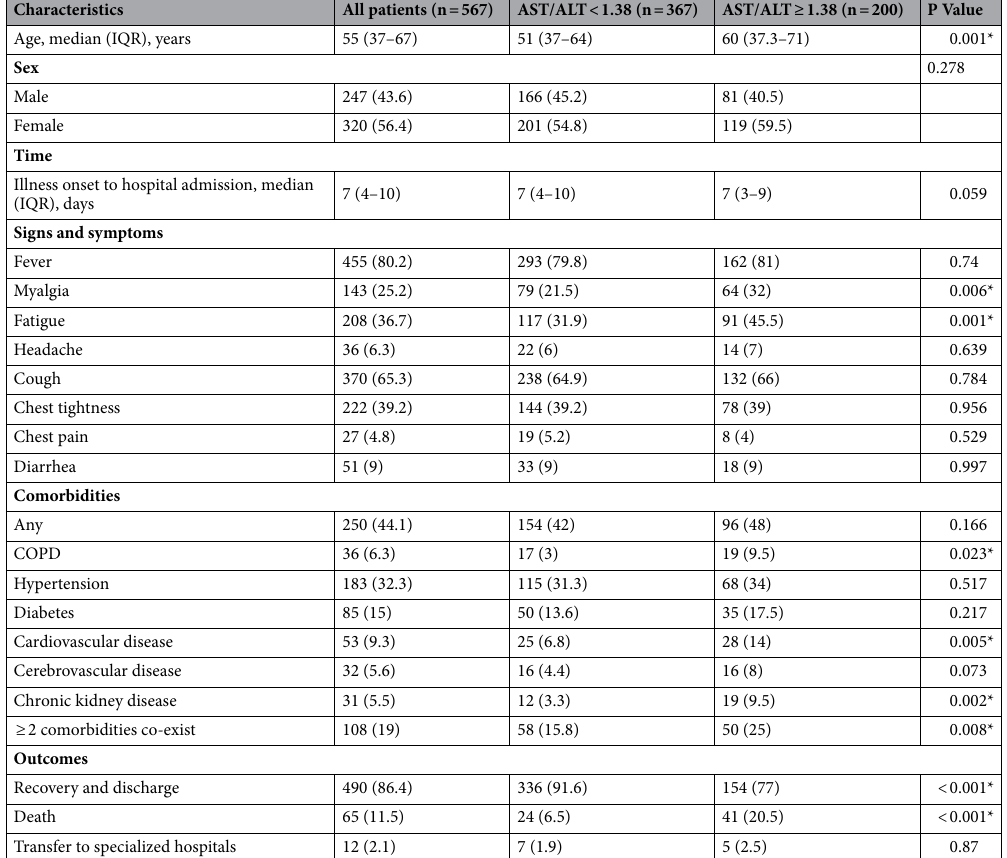
Characteristics All patients (n = 567) AST/ALT < 1.38 (n = 367) AST/ALT ≥ 1.38 (n = 200) P